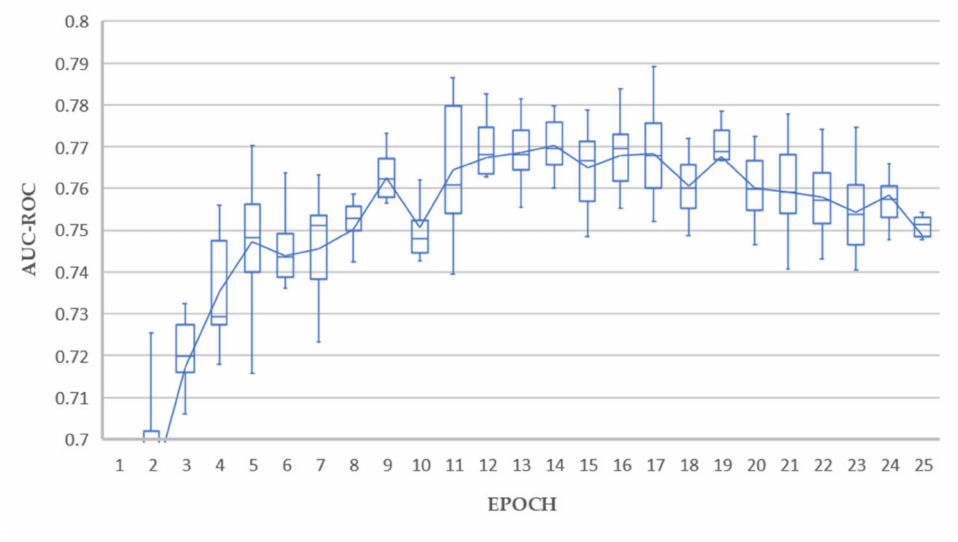
Figure 5. Average AUC-ROC for 10 rounds of holdout testing (Test A).